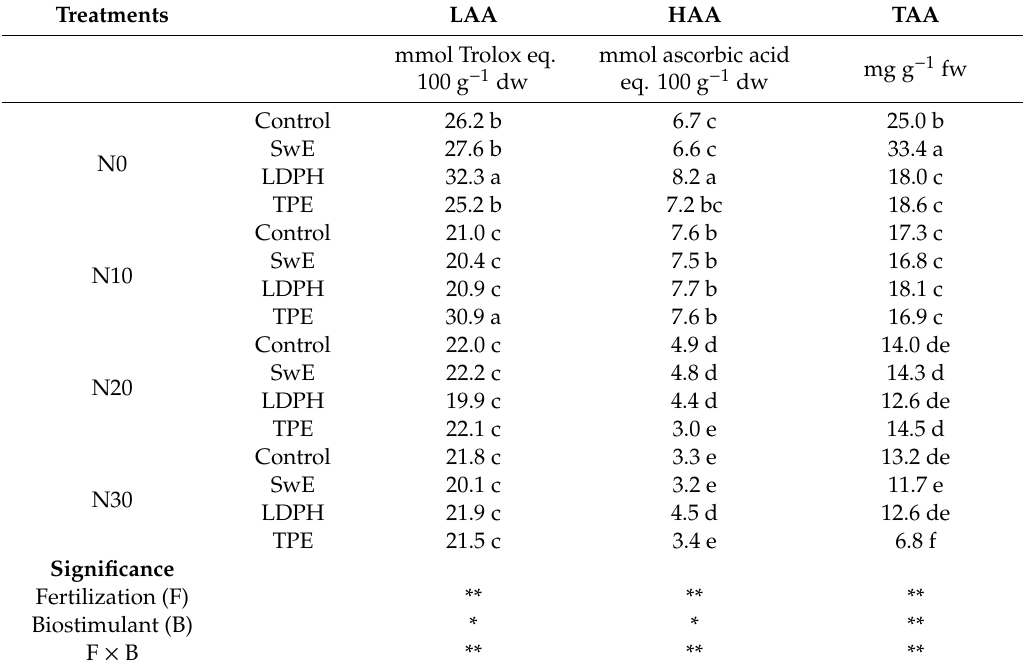
Table 5. E ff ects of nitrogen (N) fertilization levels (0, 10, 20 and 30 kg N ha − 1 ; N0, N10, N20 and N30, respectively) and biostimulant applications (untreated control, SwE: Extract of seaweed Ecklonia maxima , LDPH: Legume-derived protein hydrolysate and TPE: Tropical plant extract) lipophilic (LAA) and hydrophilic (HAA) antioxidant activities and total ascorbic acid (TAA) of baby lettuce plants.